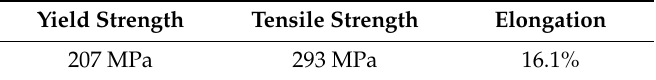
Table 2. Mechanical properties of AA2519 extrusion to be welded.